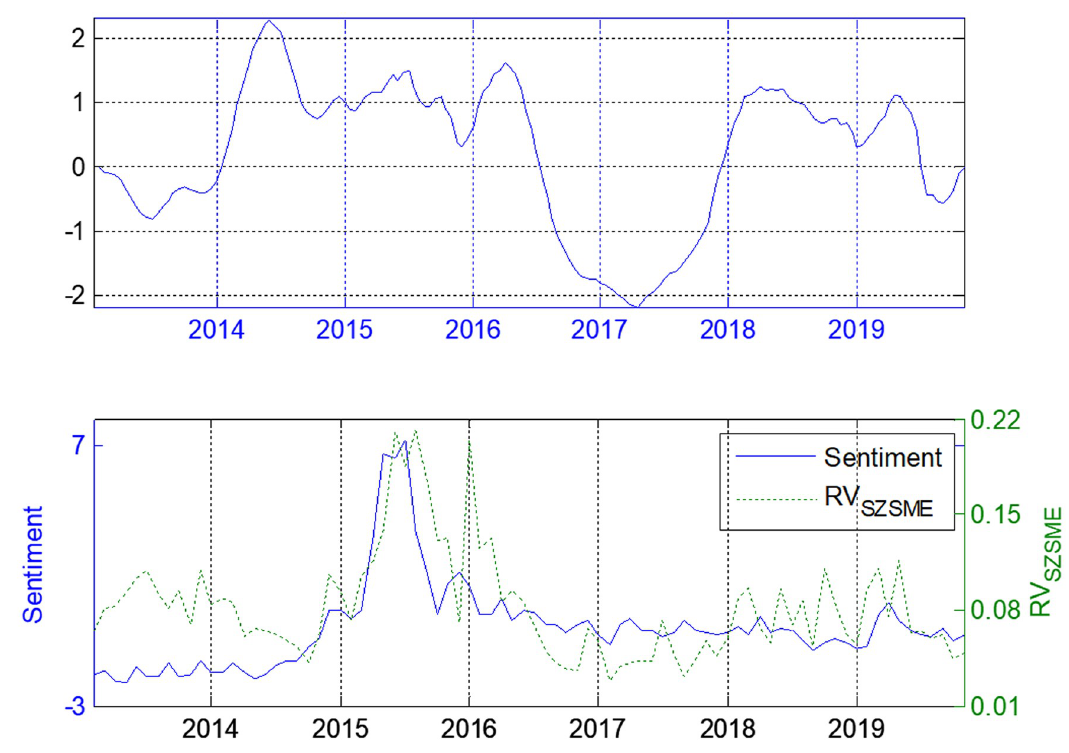
Fig 6. Lead-lag structure for investor sentiment and SZSME Price Index.